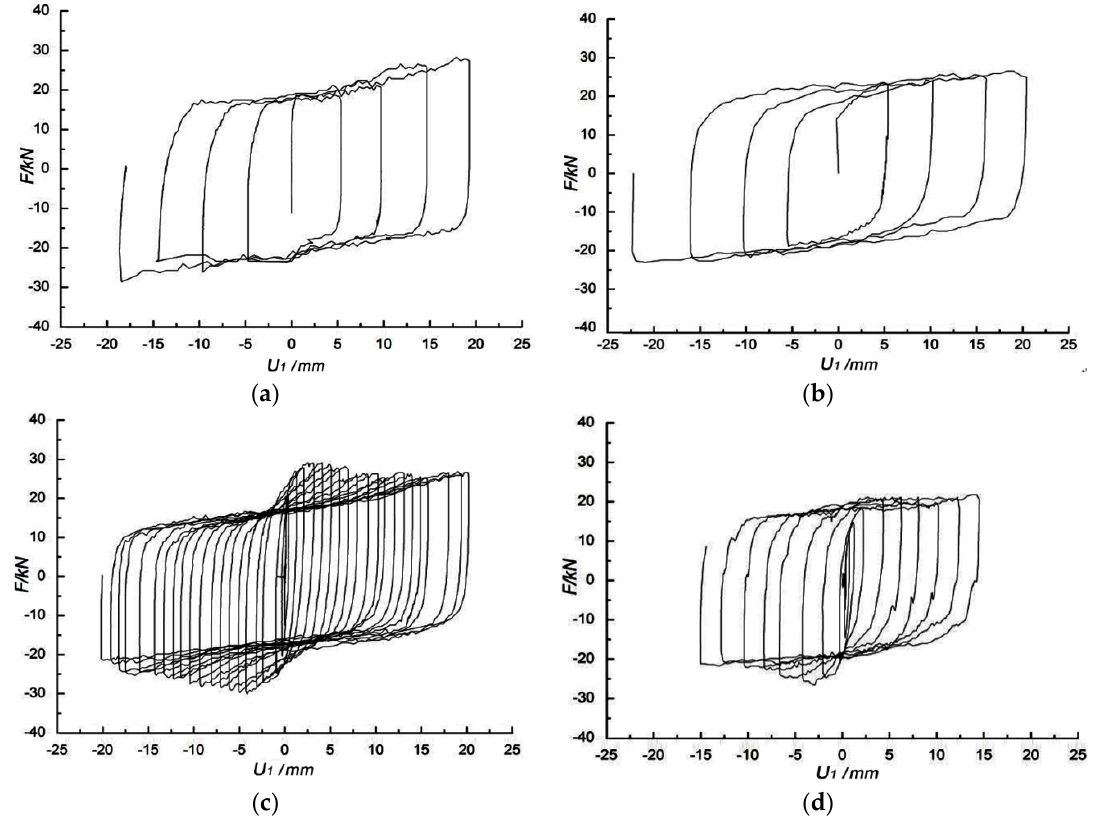
Figure 18. Force ‐ bearing performance of mortar bars. ( a ) GGBW ‐ 1; ( b ) GGBW ‐ 2; ( c ) GGBW ‐ 3; ( d ) Figure 18. Force-bearing performance of mortar bars. ( a ) GGBW-1; ( b ) GGBW-2; ( c ) GGBW-3; GGBW ‐ 4. ( d )